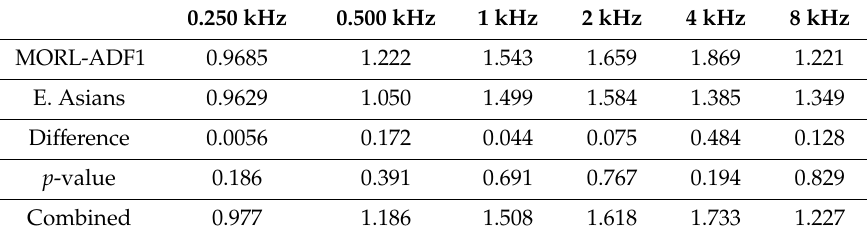
Table 1. Progression rates by